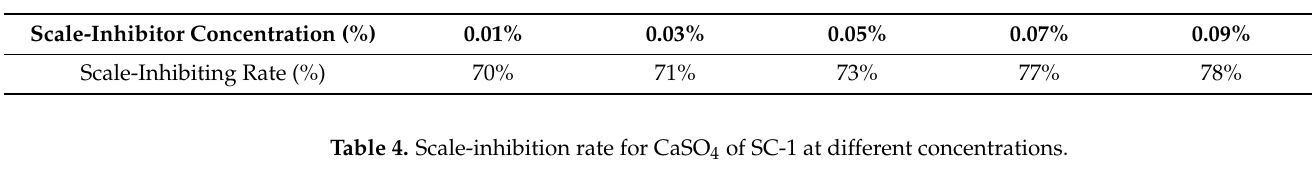
Table 3. Scale-inhibition rate for CaCO 3 of SC-1 at different concentrations.